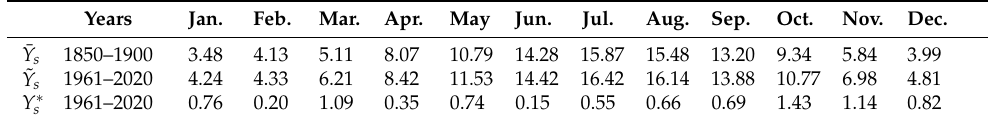
Table 1. Mean monthly temperatures ( ◦ C) for years 1850 until 1900 ¯ Y s (first row) and years 1961 until 2020 ˜ Y s (second row). The third row displays corresponding anomalies Y ∗ s for years 1961 until 2020. Years Jan. Feb. Mar. Apr. May Jun. Jul. Aug. Sep. Oct. Nov. Dec.